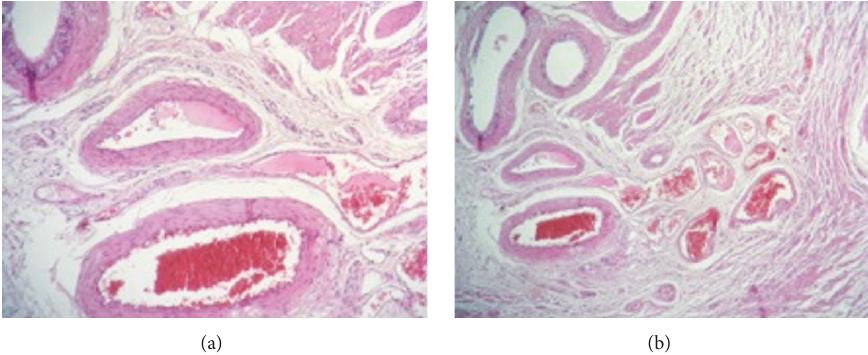
Figure 2: Important vascular proliferation. Vessels are enlarged, laying in an abundant connective tissue.